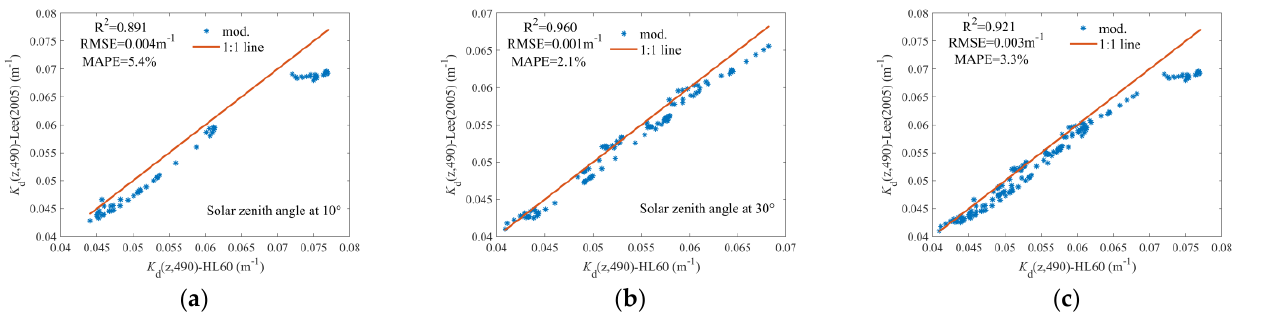
Figure 13. Comparisons of 𝐾 𝑑 (𝑧, 490) calculated by HL60 and the model of Lee (2005): ( a )